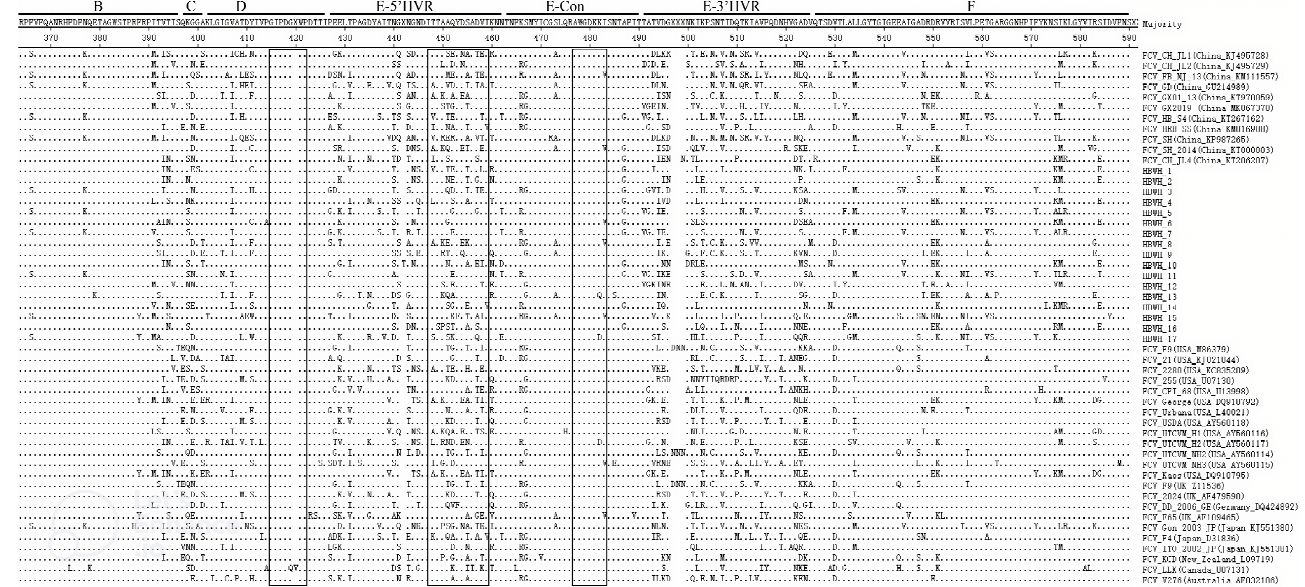
Figure 4. Amino acid site mutation analysis of isolates and reference strains performed in the ORF2 region (B–F) of the capsid protein gene proposed by Seal [25]. (Inside the box is the epitope region of the VP1